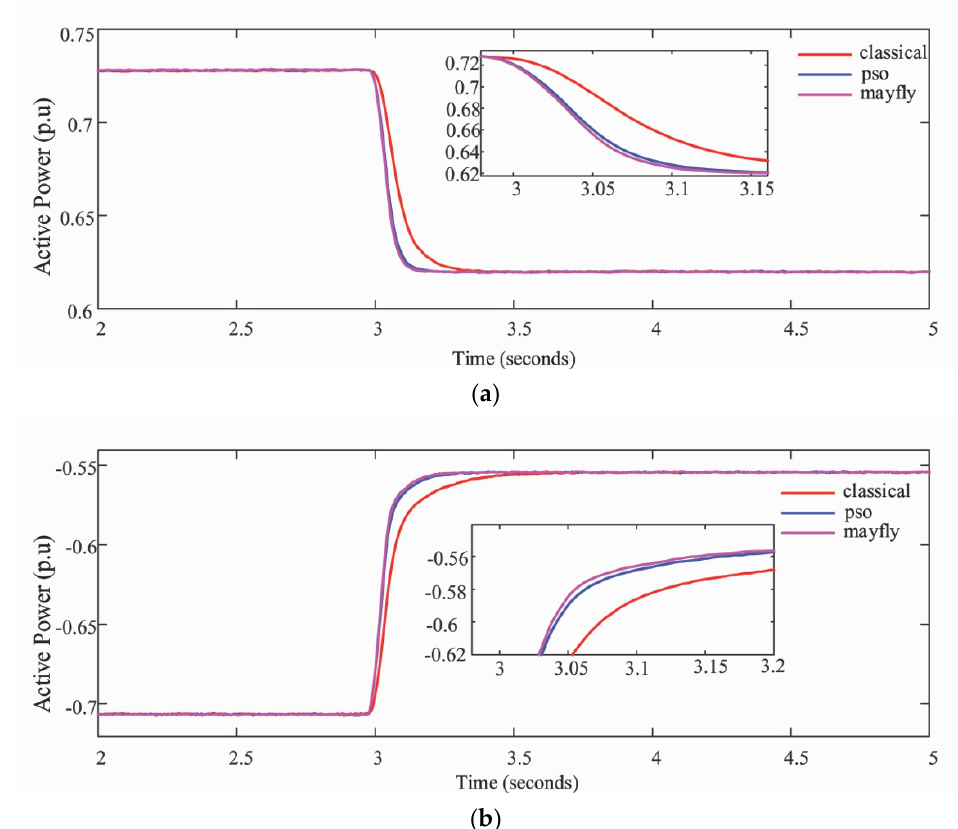
Figure 17. Change in power at wind farms: ( a ) power ramp at wind farm 1; ( b ) change in demand at grid side 2.